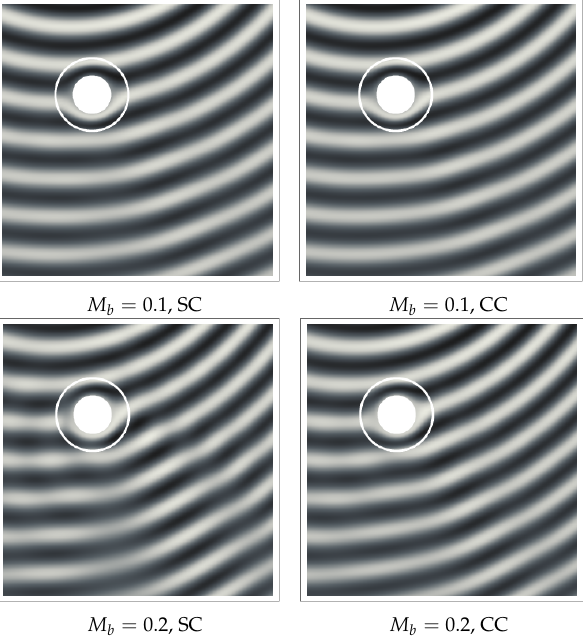
Figure 13. Field of total pressure in Ω c ∪ Ω h . Comparison of results obtained with static (SC) and convected (CC) cloaks at ka =